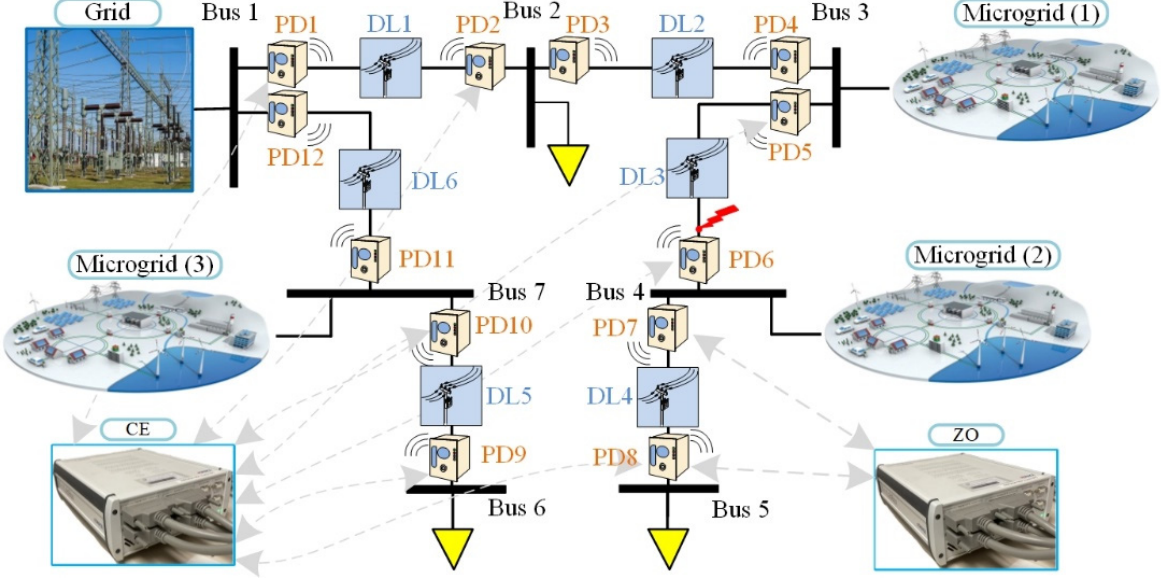
Figure 1. Single line diagram of a distribution system with DG penetration and Centralized (CE)/Zone (ZO) control topologies.